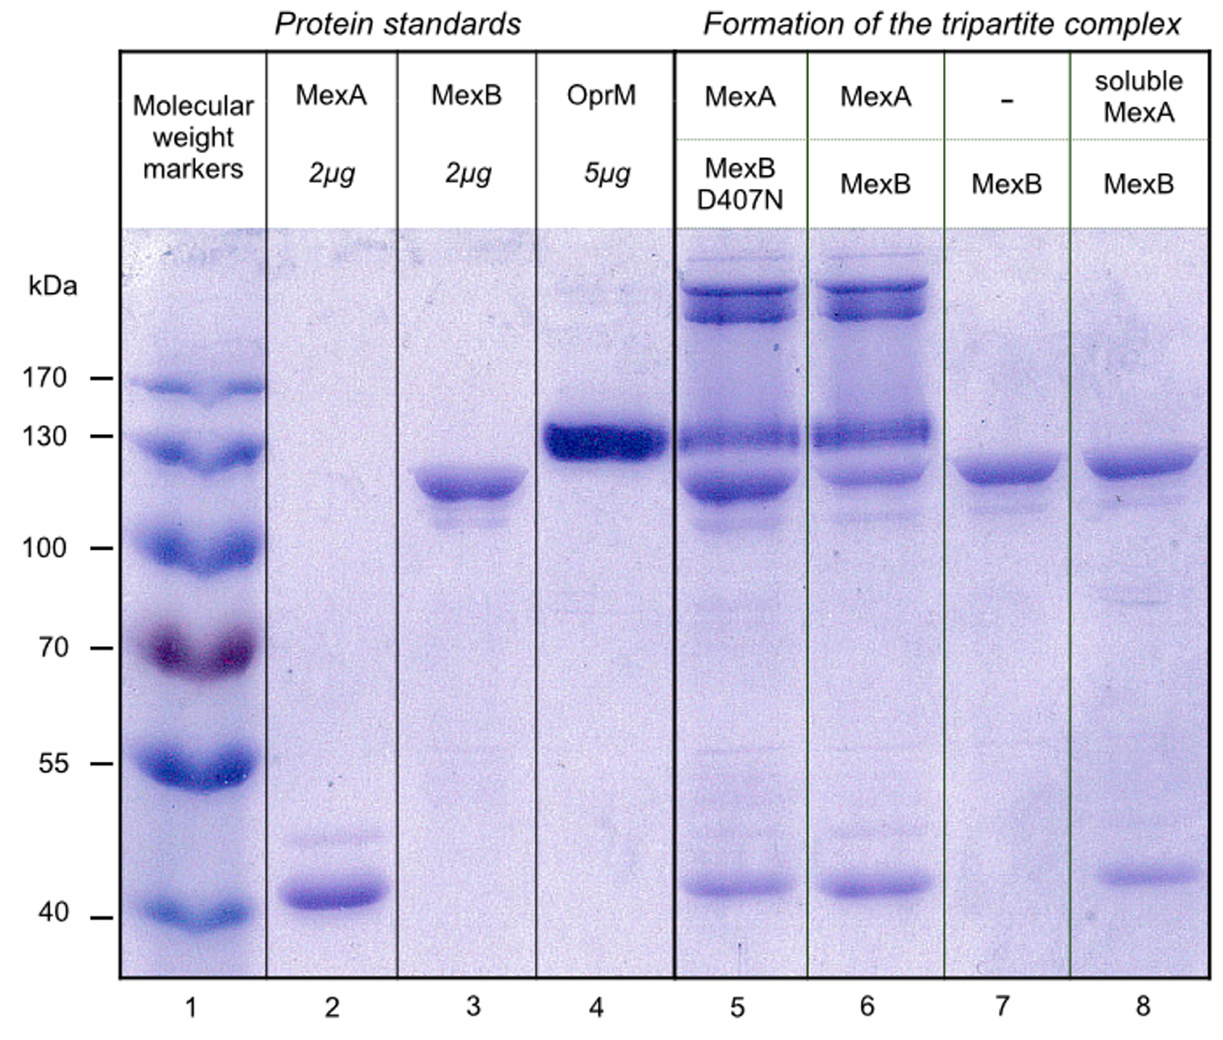
containing MexA and MexB (lane 5), MexA and MexB D407N (lane 6), MexB alone (lane 7), or MexB in the presence of a soluble version of MexA (lane 8) were mixed with proteoliposomes containing OprM as described in the Material and Methods section. Liposomes were sedimented and the pellets were mixed with 5 µ L loading buffer before being loaded on the gel. The samples were not boiled in order to avoid aggregation of the membrane